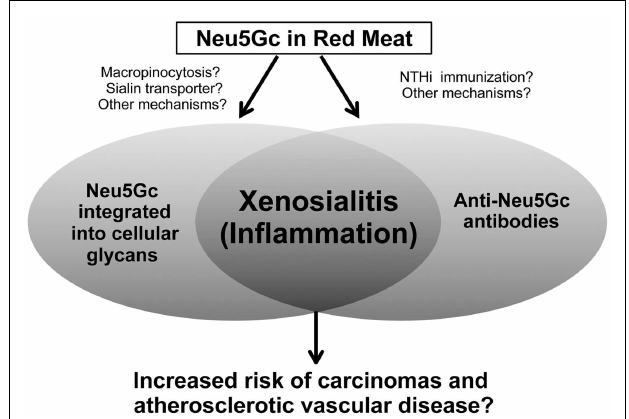
FIGURE 3 | Xenosialitis hypothesis . Neu5Gc is metabolically incorporated from the diet (primarily red meats) into cellular glycans to form xeno-autoantigens. Anti-Neu5Gc antibodies or xeno-autoantibodies are induced by immunization via commensal bacteria (such as non-typeable Haemophilus influenza or NTHi) that scavenge and express Neu5Gc.The resulting antigen–antibody interaction is hypothesized to lead to chronic inflammation termed xenosialitis that potentially promote cancer and/or atherosclerotic vascular disease.